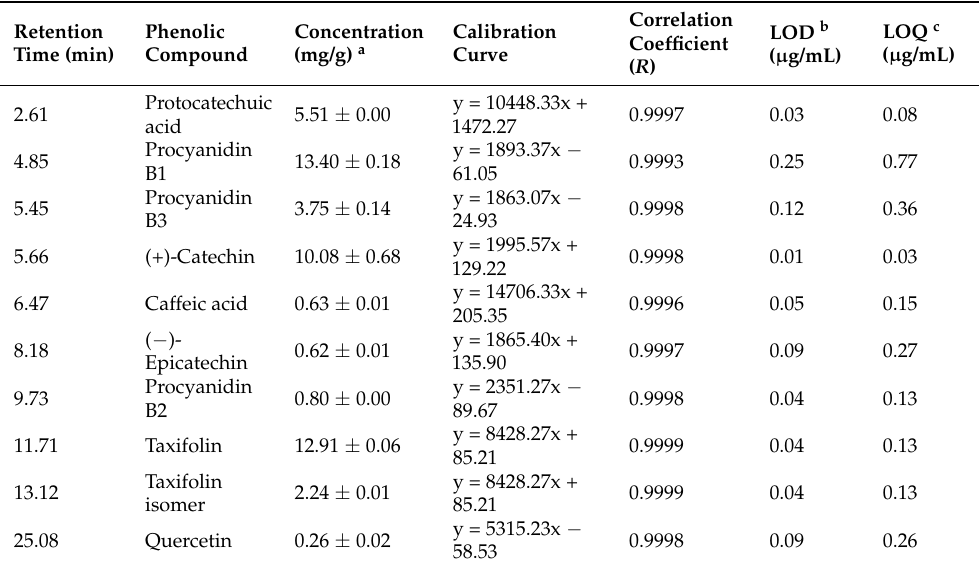
Table 2. Concentrations and quality parameters of phenolic compounds in